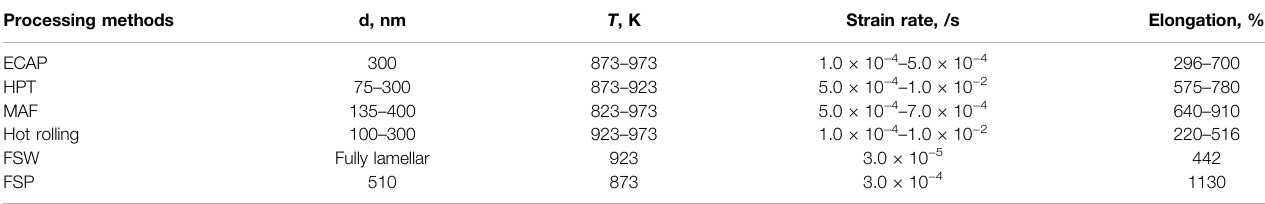
TABLE 1 | Maximum elongations for the LTSP (below 973 K) in the SPDed Ti-6Al-4V alloy (Kim et al., 1998; Salishchev et al., 2001; Ko et al., 2005; Ko et al., 2006; Matsumoto et al., 2013; Zhang et al., 2014a; Fu et al., 2015; Wu et al., 2016; Zhang et al., 2018a).